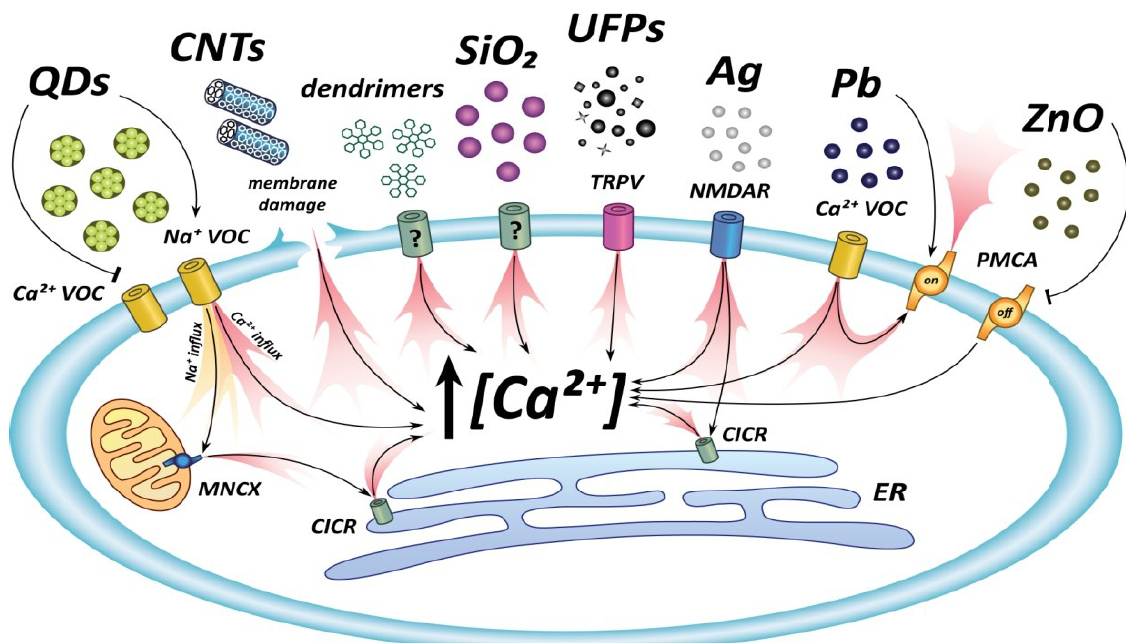
Figure 1. The most relevant calcium mobilizing pathways modulated by NPs in neuronal